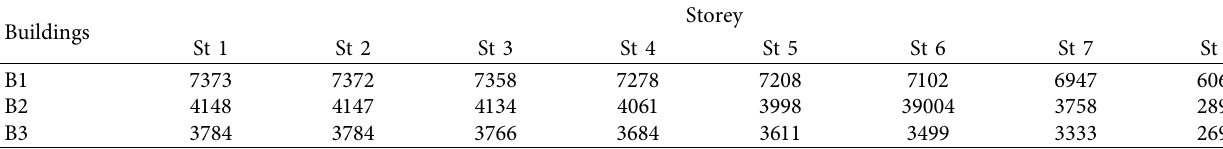
Figure 3: Plan of buildings: (a) plan of building B1 and building B2 and (b) plan of building B3. Table 1: Translational weights (kN) of buildings.